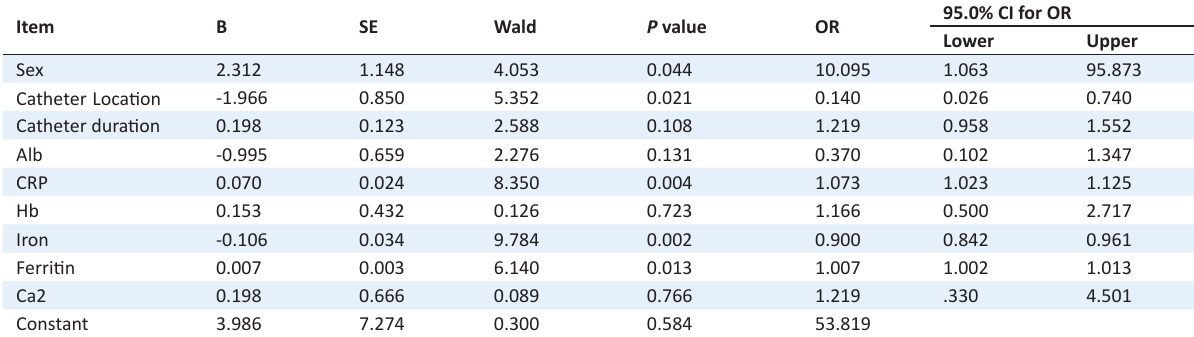
Table 2. Multivariable logistic regression model to predict TCC infection in hemodialysis